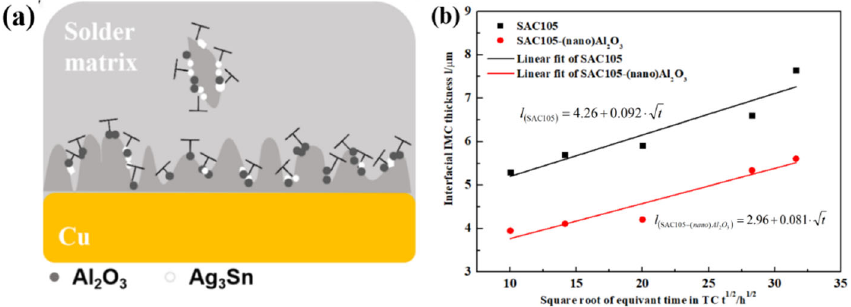
Figure 6. ( a ) Distributed illustration of nano ‐ Al 2 O 3 and Ag 3 Sn IMCs; ( b ) Thickness of the interfacial IMCs at SAC105/Cu and SAC105 ‐ (nano)Al 2 O 3 /Cu interface subjected to TC.